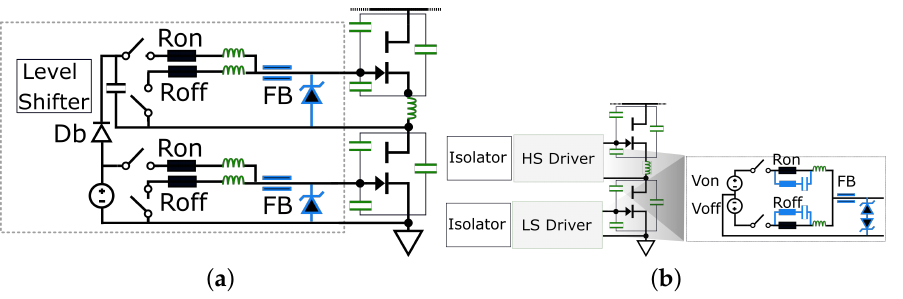
Figure 6. Practical GaN transistor gate driver alternatives based on ( a ) bootstrap [9,74] supply ( b ), isolated supply [9,74]. Blue printed and green printed symbols represent optional components and parasitic circuit elements